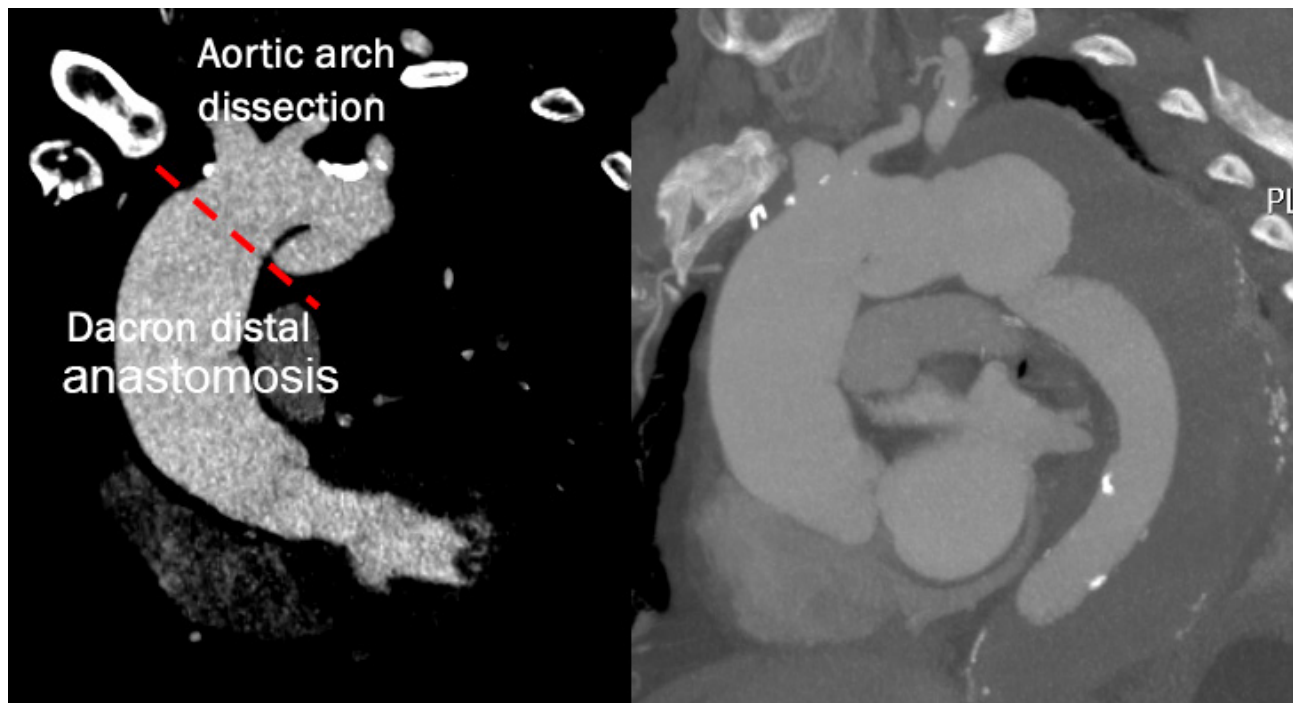
Fig. 1 - Preoperative computed tomography angiography showing a huge aortic arch aneurism and